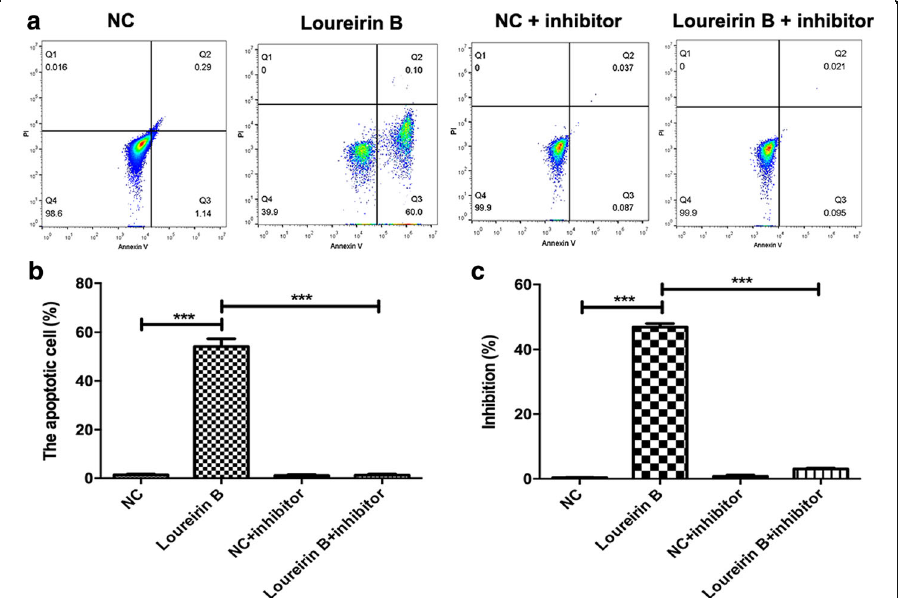
Fig. 6 Loureirin B inhibits the proliferation and promotes the apoptosis of HSCs via regulation of miR-148-3p. a and b Flow cytometry was used to analyze the apoptosis of HSCs when inhibitor was applied to silence the miR-148-3p expression. c The proliferation of HSCs was detected using the MTT assay. Data are the means ± SEM from four independent experiments. * p <0.05; ** p <0.01; *** p